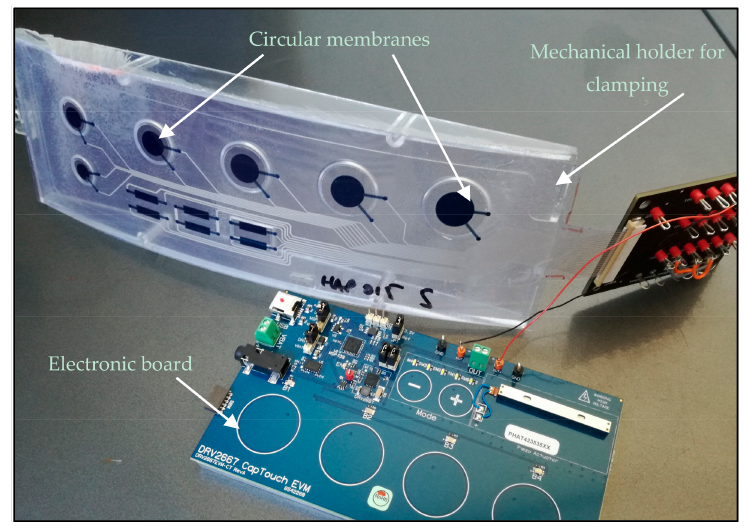
Figure 9. Demonstrator integrating vibrotactile buttons actuated by electro-active